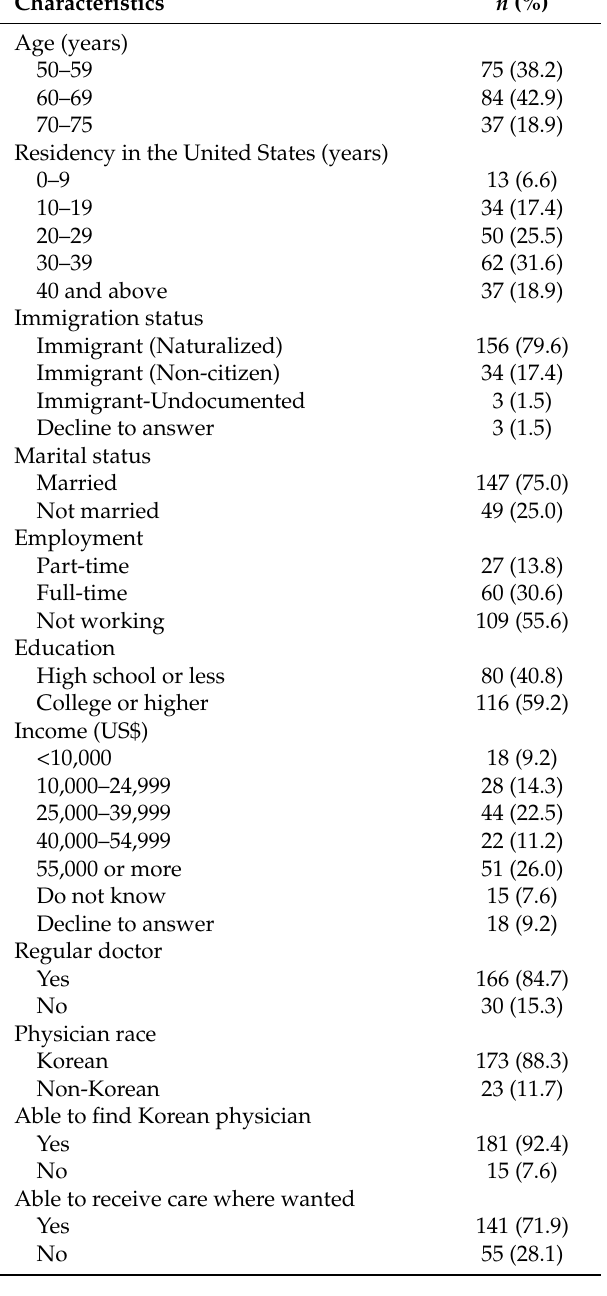
Table 1. Descriptive statistics of the participants ( N =